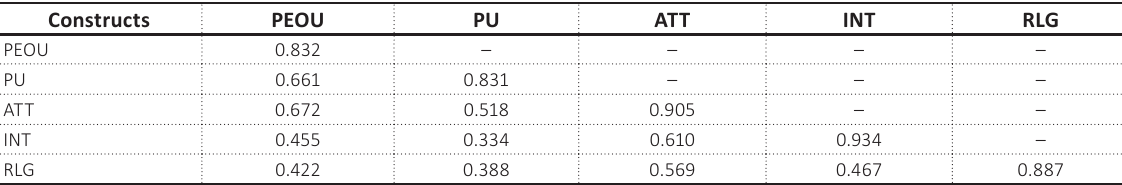
Table 2. The square root of AVE and correlation coefficients